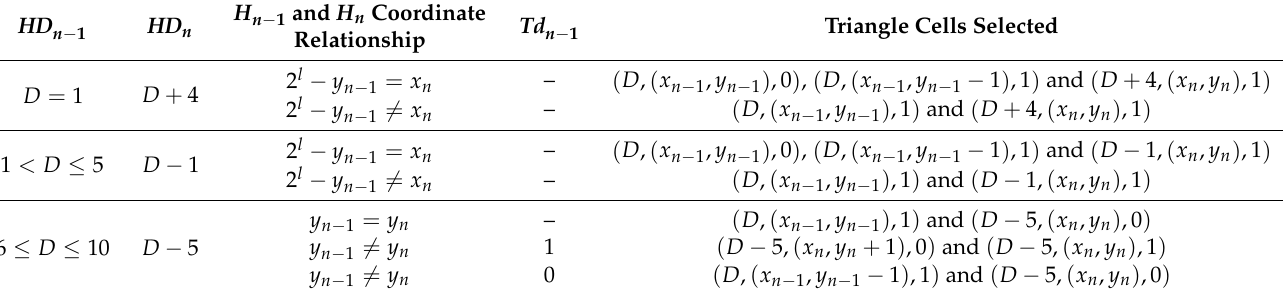
Table 7. Htotcode rule of the ( n − 1)th hexagon cell B 4 .